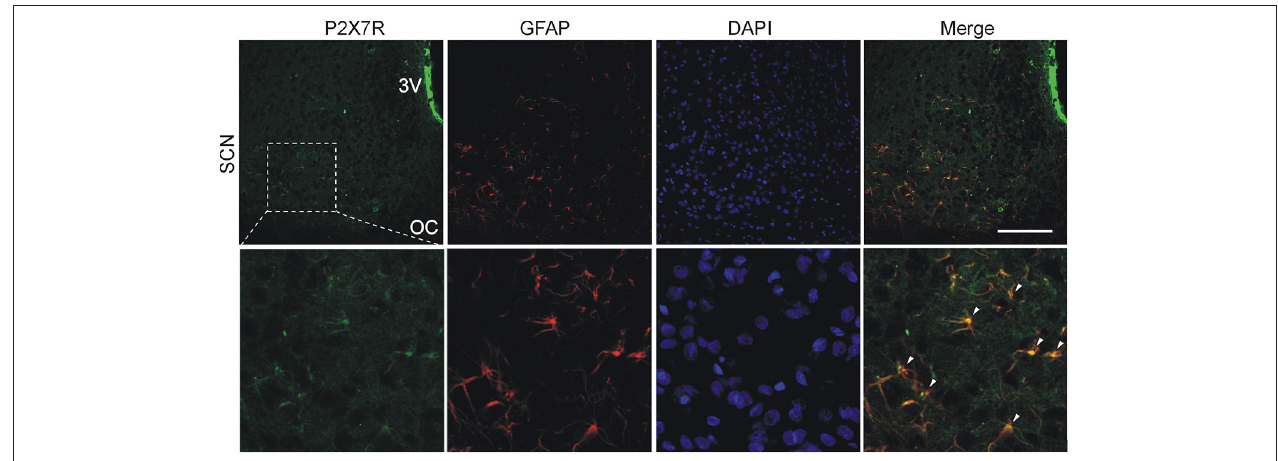
FIGURE 4 | Cellular localization of P2X7Rs in the SCN. Immunohistochemical staining of rat hypothalamic slices containing the SCN, optic chiasm (OC) and the third ventricle (3V). P2X7R immunoreactivity (green) is present on SCN cell somata. DAPI (blue) stains cell nuclei and astrocytes were identified using anti-GFAP antibodies (red). Scale bar: 100 µ m (upper row) . Colocalization of P2X7R with the astrocyte marker. Arrowheads show representative structures that are double-labeled with anti-P2X7R and anti-GFAP antibodies (lower row) . Figure represents example of experiment that was performed on three animals.